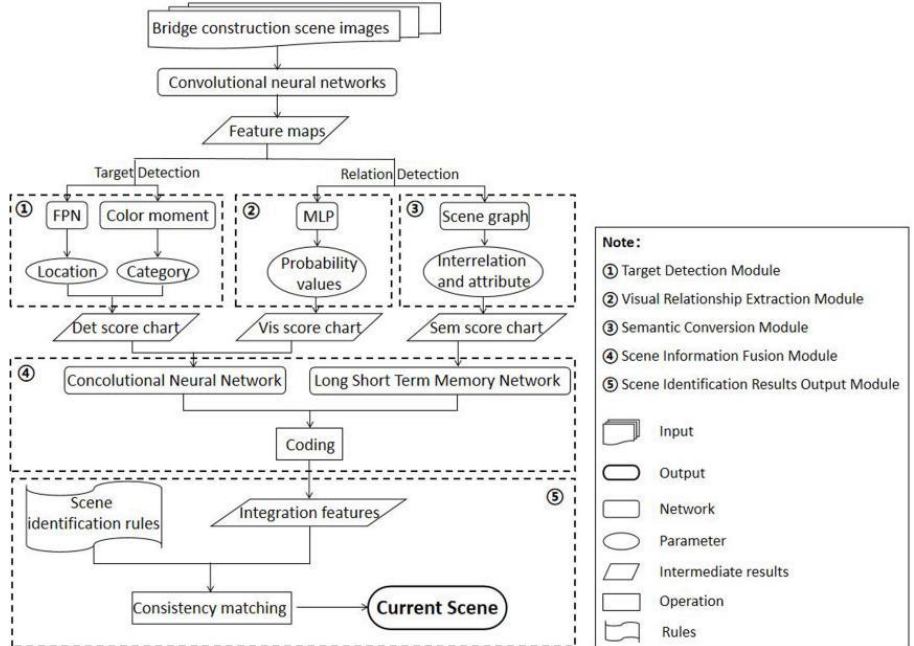
Figure 4. Method flow-chart.